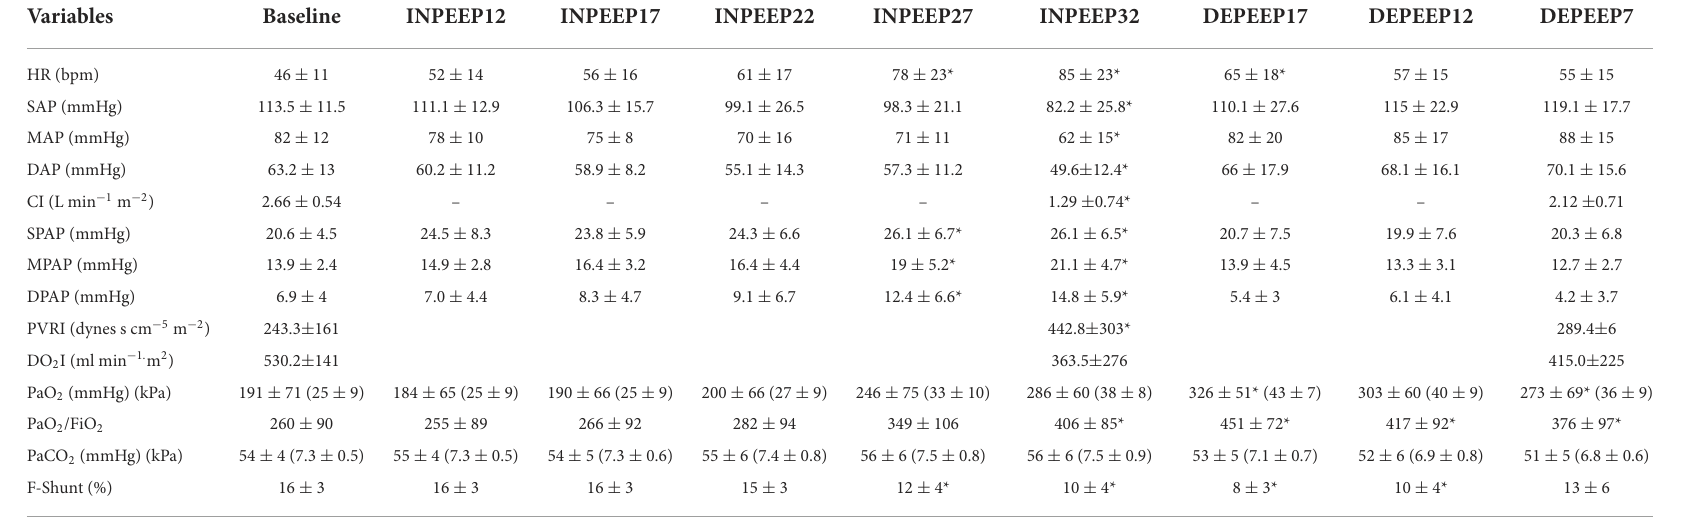
TABLE 2 Gas exchange and hemodynamics